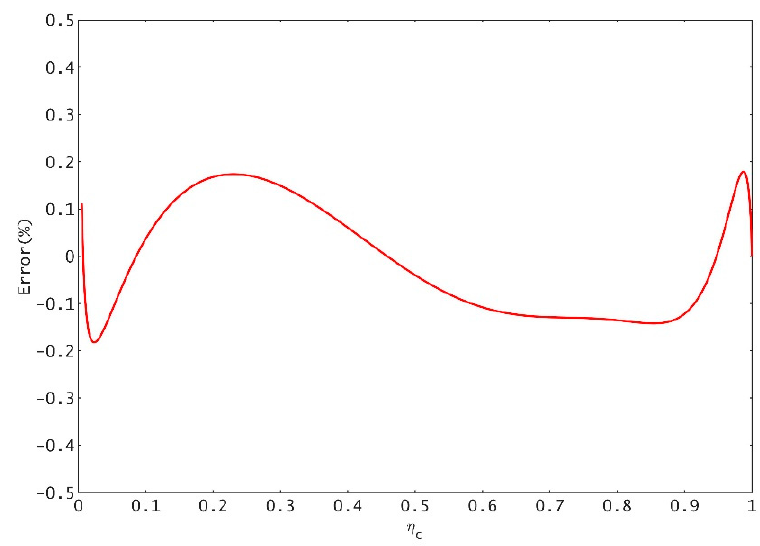
Figure 7. Error analysis of the critical depth formula for circular sections.